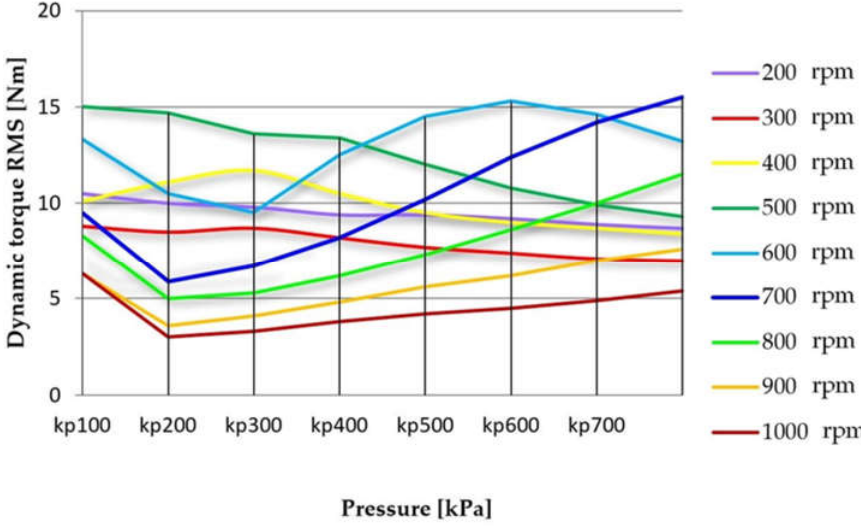
Figure 12. Measurement in range of operating speed—a run of all cylinders.